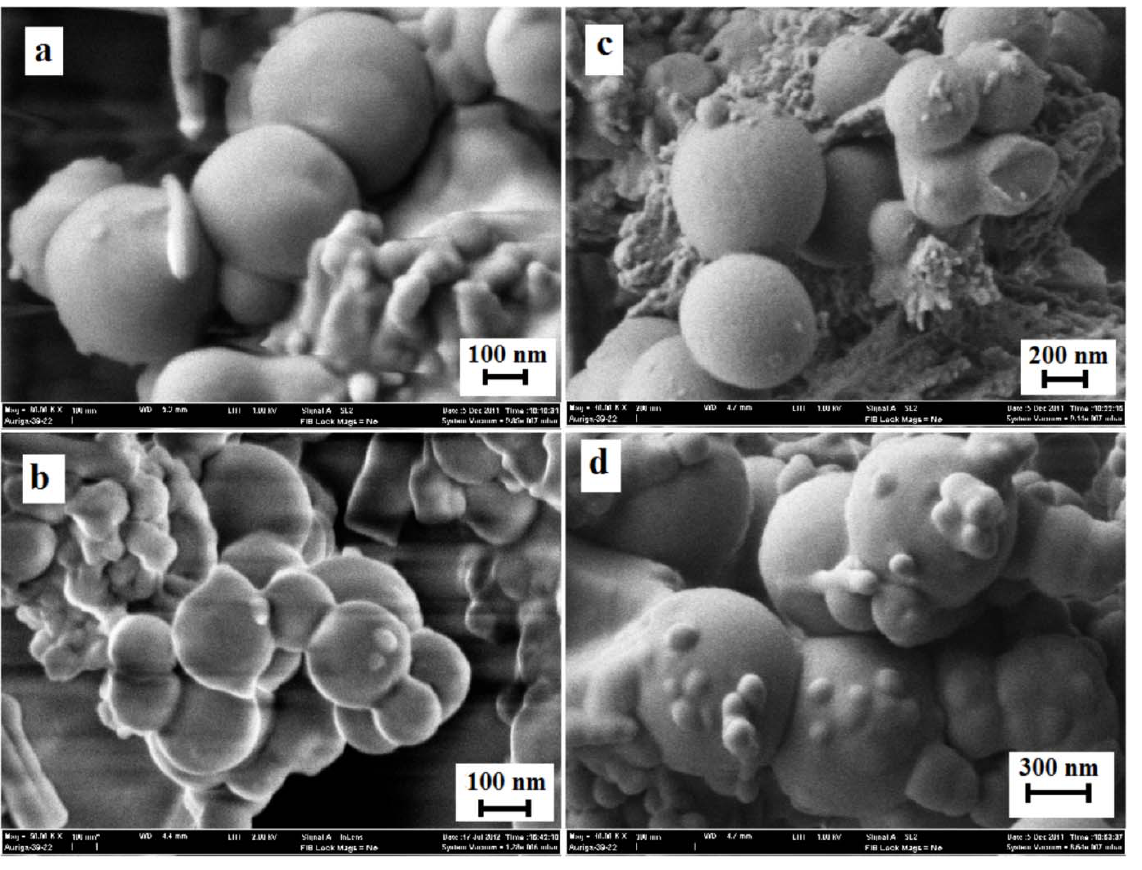
Figure 7. ( a ) Microcapsules S1 after 0 cycle; ( b ) microcapsules S1 after 1000 cycles; ( c ) microcapsules S2 after 0 cycle; and ( d ) microcapsules S2 after 1000